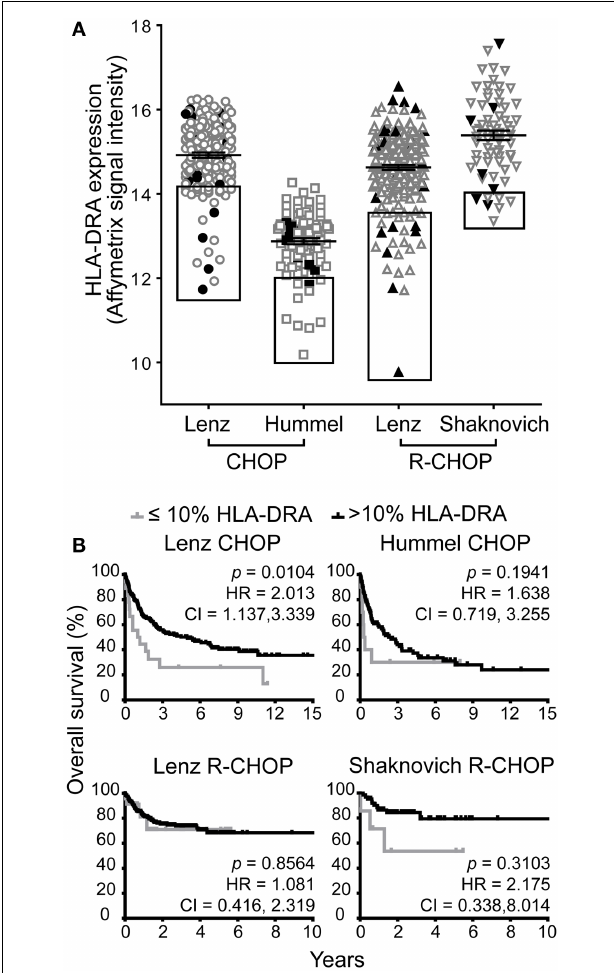
FIGURE 2 | Low HLA-DRA gene expression is associated with poor survival in one of four DBLCL cohorts . (A) The relative mRNA expression of HLA-DRA in each patient in the four cohorts. Each symbol represents a single patient.The line and error bars indicate the mean ± SEM.The box indicates the 10% of patients with the lowest HLA-DRA expression.The closed, black symbols denote the 10% of patients with the lowest GILT expression shown in the boxes in Figure 1A . (B) Kaplan–Meier survival curves comparing patients with ≤ 10% expression of HLA-DRA (gray line) to patients with > 10% expression (black line).The p -values, hazard ratio (HR), and 95% confidence interval (CI) comparing survival of patients with ≤ 10 and > 10% expression of HLA-DRA are indicated for each cohort. Lenz CHOP: n = 18 ≤ 10% HLA-DRA, n = 163 > 10% HLA-DRA, Hummel